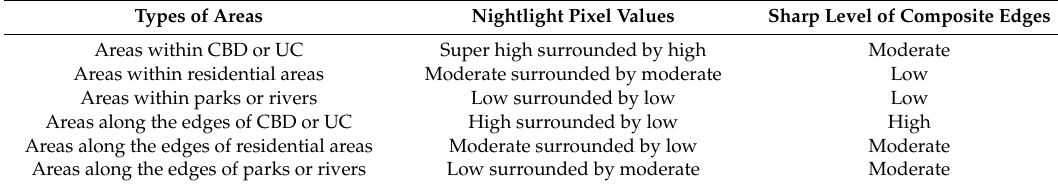
Figure 1. Nightlight Satellite Data of Cincinnati in 2012 from the band Day/Night Band (DNB) in the Visible Infrared Imaging Radiometer Suite sensor on the Suomi National Polar-Orbiting Partnership Satellite (NPP-VIIRS). Table 1. Examples of areas and their corresponding composite edges measured by nightlight satellite data.